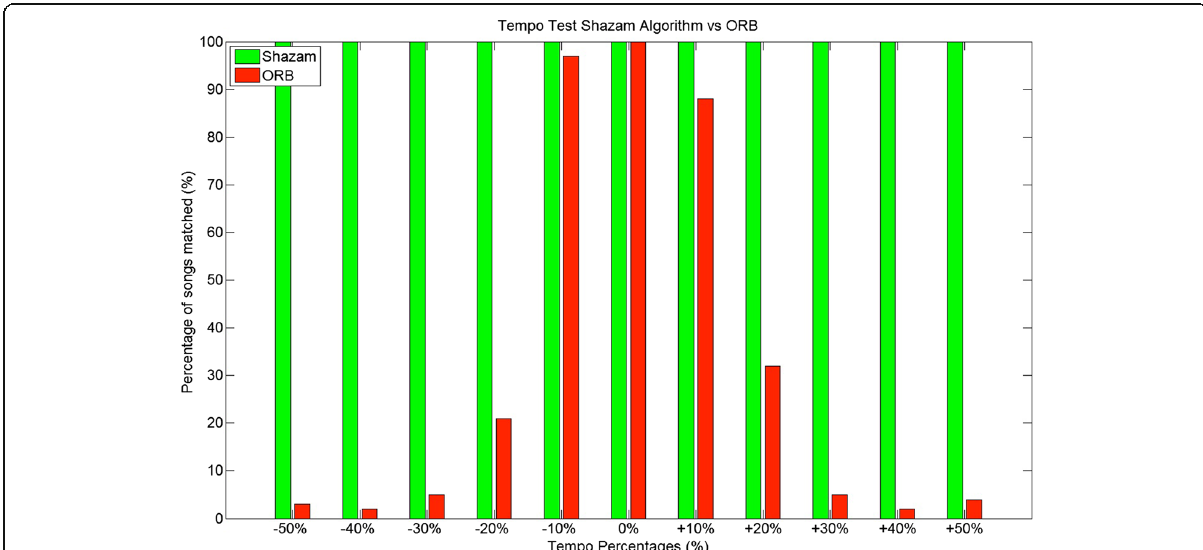
Fig. 5 Tempo test for robustness (Shazam vs ORB). This figure shows the results for the tempo being changed by a range from − 50 to +50% to test the limits. This type of distortion is known as time stretching or time scaling. The speed of the audio clip is altered while the pitch remains constant. On the spectrogram, this change would be seen on the time axis (temporally) but no change on the frequency axis (pitch). The experiment was carried out where a random 20-s sample was taken from each song in the database, and the tempo change was applied. The distorted samples were then queried to the test if they accurately matched. It was seen that the Shazam algorithm produced better results compared to the ORB